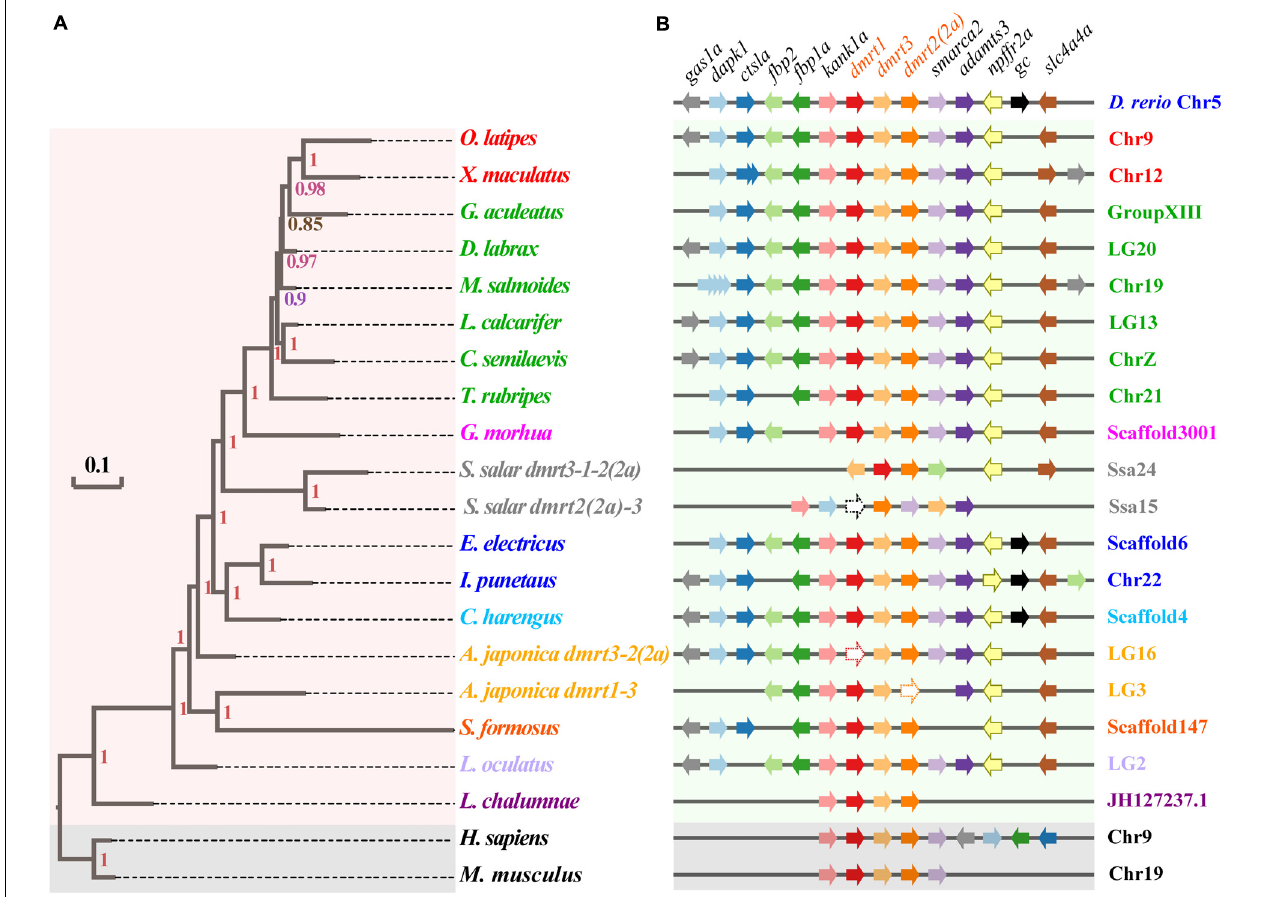
FIGURE 2 | Phylogenetic tree and synteny conservation of the fish dmrt1 - dmrt3 - dmrt2(2a) gene clusters. (A) The rectangular Bayesian phylogenetic tree, rooted with human and mouse sequences. Numbers besides the nodes are Bayesian posterior probabilities (colored). (B) The synteny of examined dmrt1 - dmrt3 - dmrt2(2a) gene clusters. Full names of relevant genes are provided in Supplementary Table S3